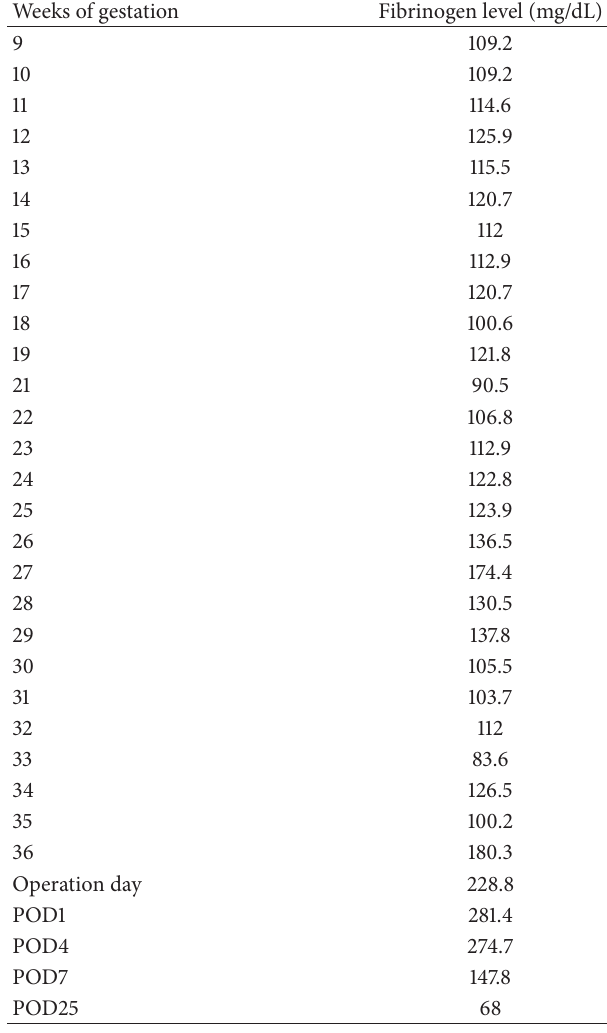
Table 2: Fibrinogen level during pregnancy in case